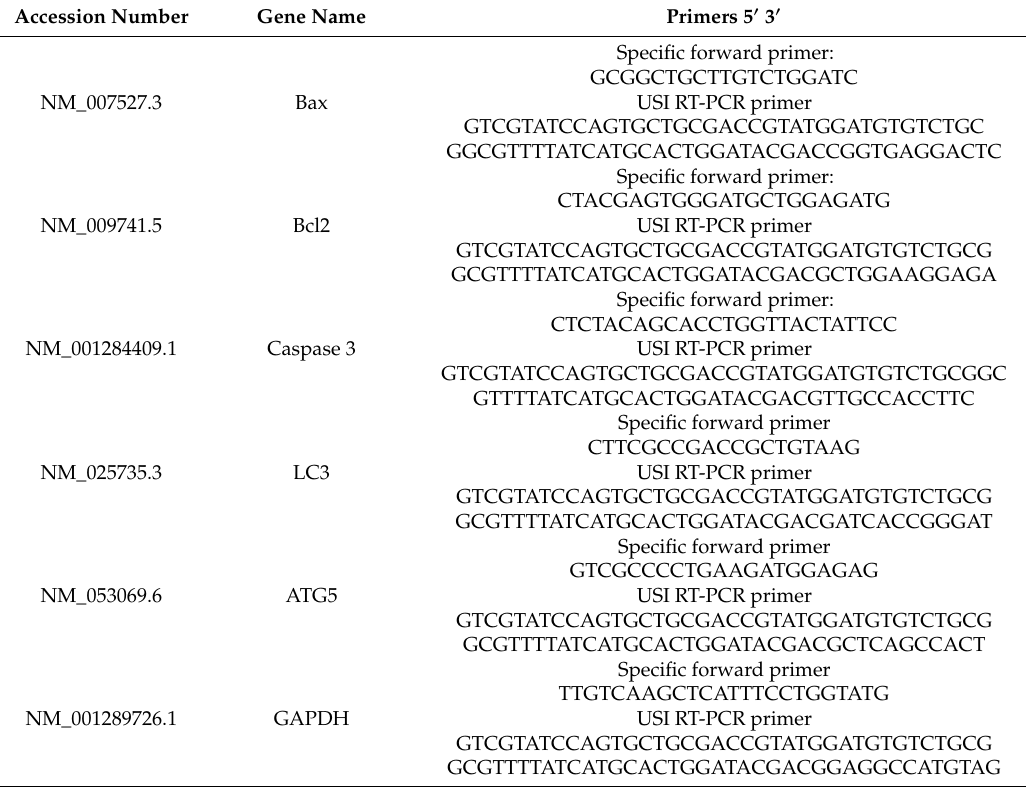
Table 1. Primer sequences used for stem-loop RT